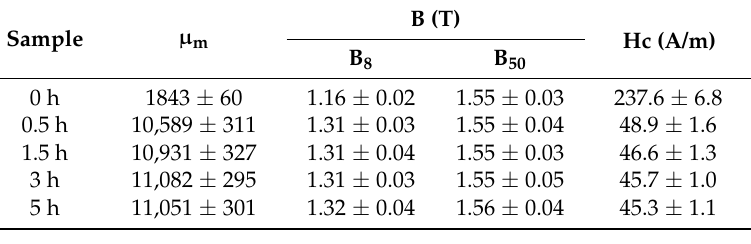
Table 1. DC properties of Fe-6.5 wt. % Si ribbons.